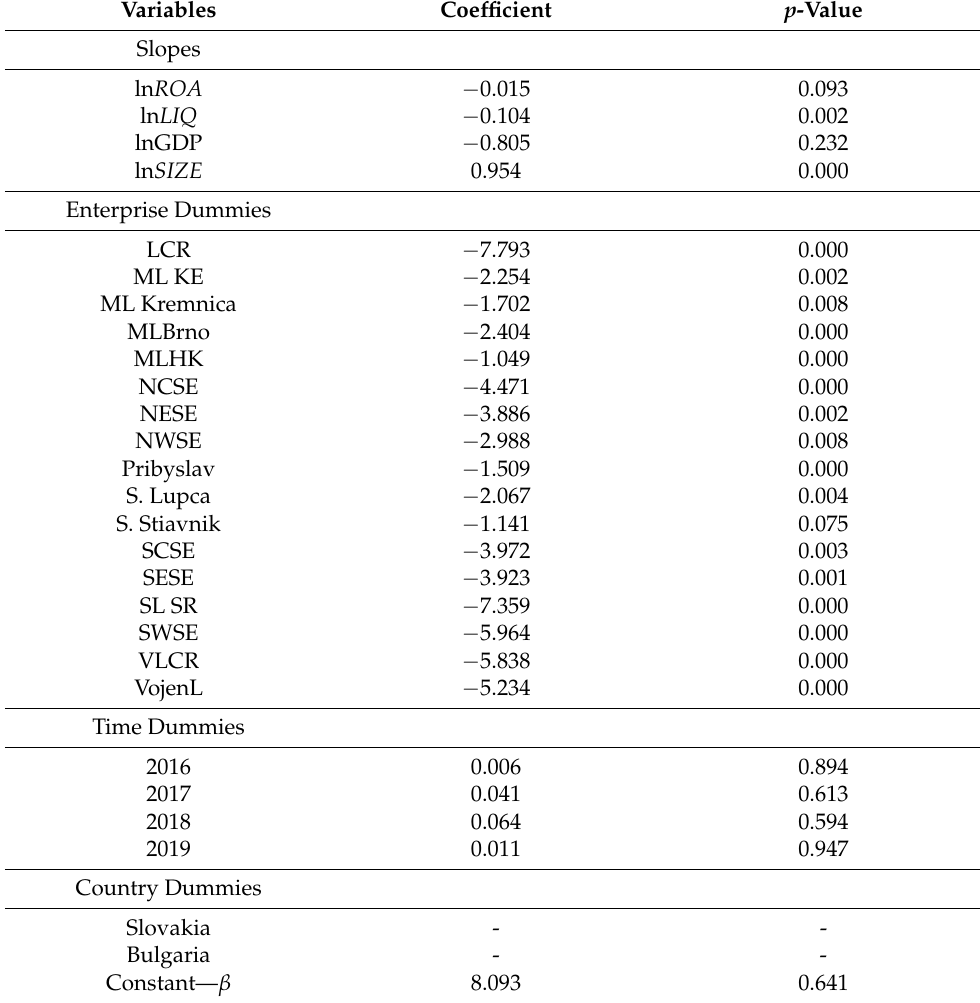
Table 5. Panel data results for model (1): α = 0.05; R =